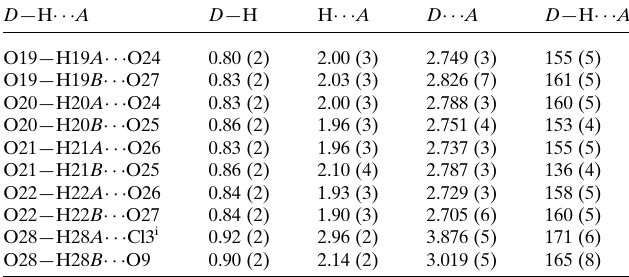
Table 9 Hydrogen-bond geometry (A˚ , (cid:4) ) for 2